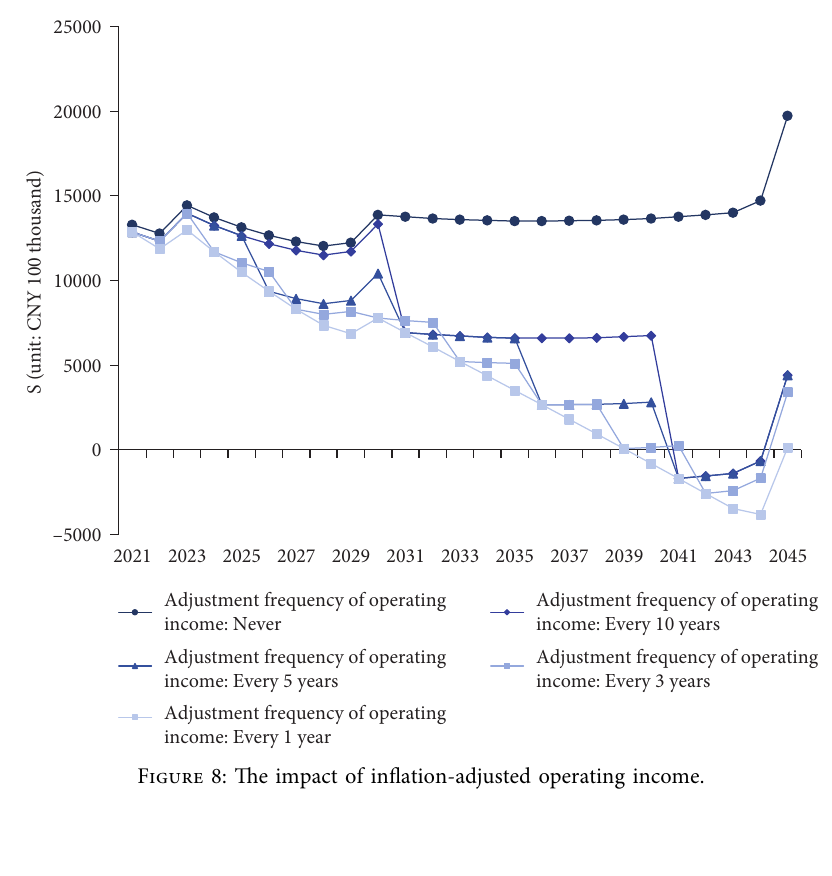
Figure 8: The impact of inflation-adjusted operating income.